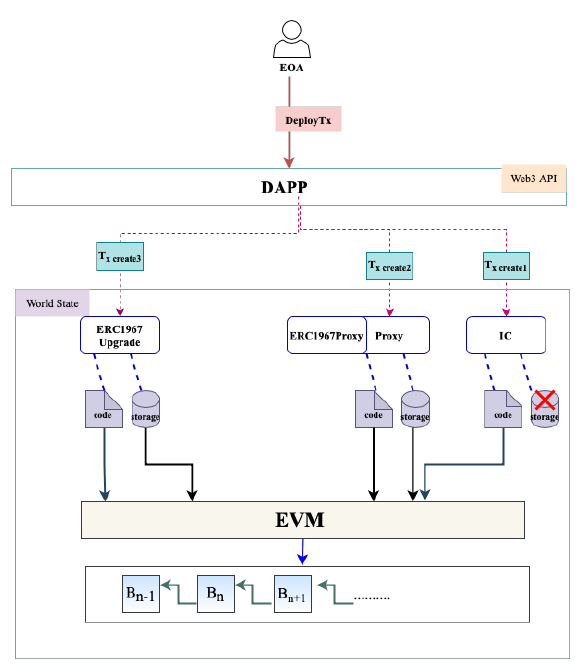
Figure 4. Process of deploying the ERC1967